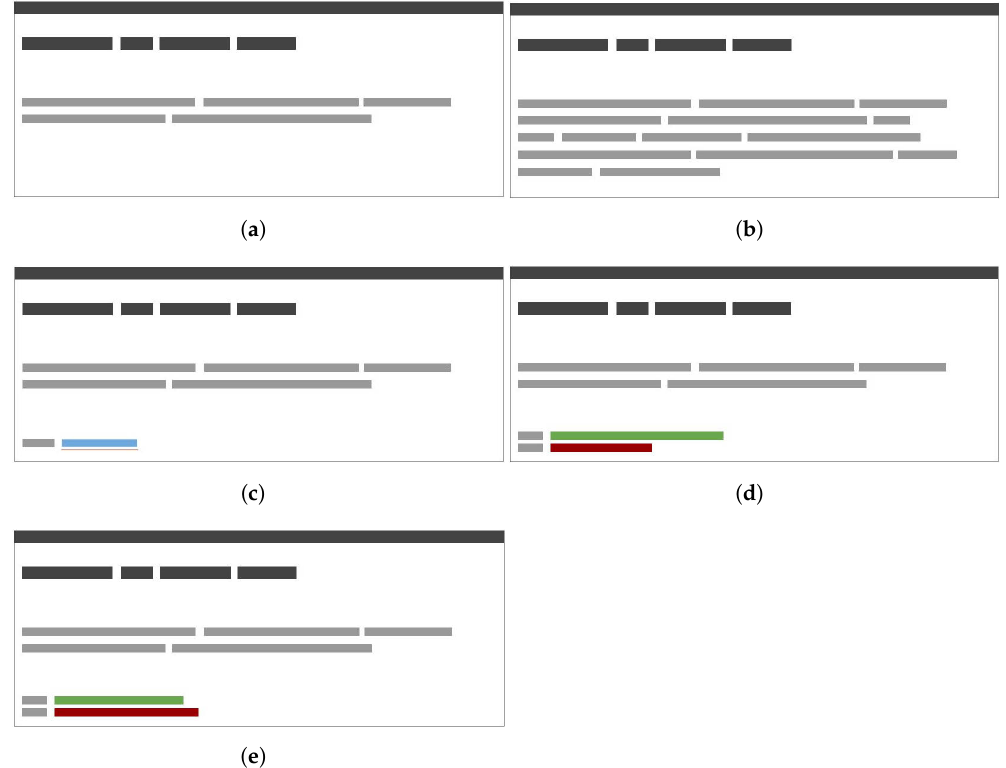
Figure 1. Graphical representation of the information displayed for each news in each room. ( a ) Room 1: News headline and short excerpt. ( b ) Room 2: News headline and full text. ( c ) Room 3: News headline and a clickable link to the source. ( d ) Room 4: News headline and other users’ ratings. ( e ) Room 5: News headline and other users’ ratings (random